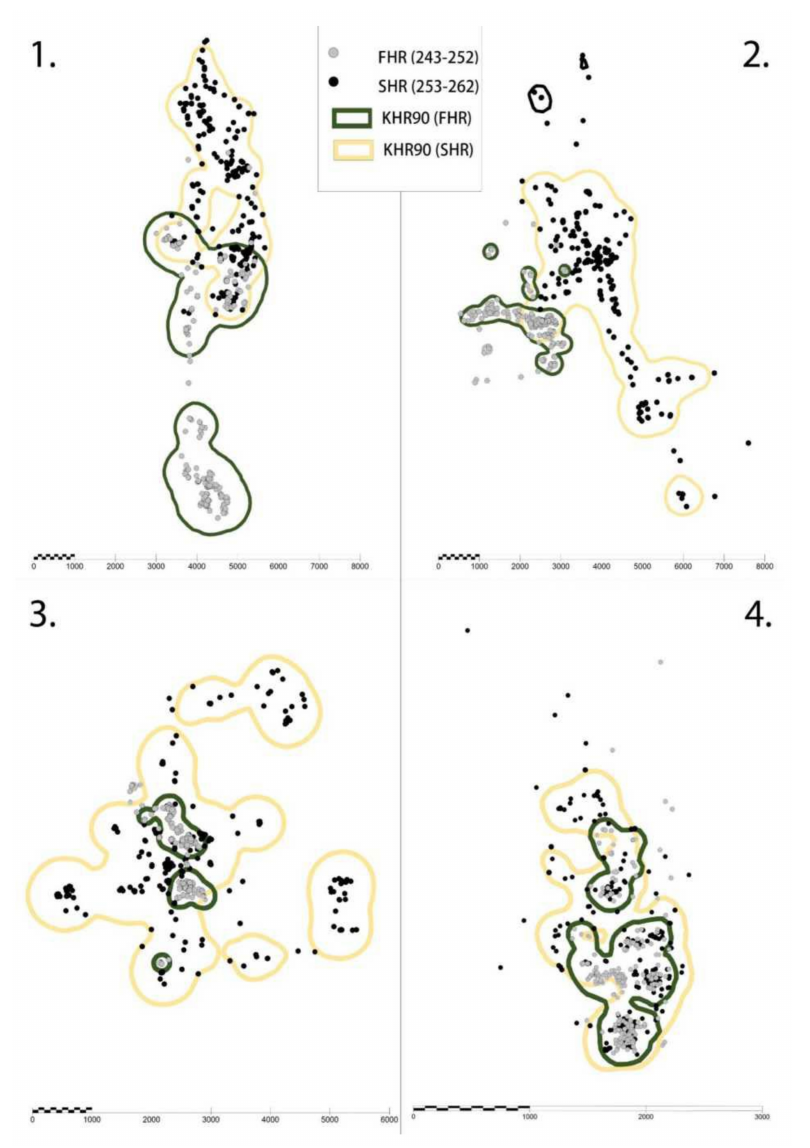
Figure 4. Detected positions of four marked red deer stags ( 1 – 4 ) and their movement range calculated by the Kernel method in the main periods First Half of Rut (FHR) and Second Half of Rut